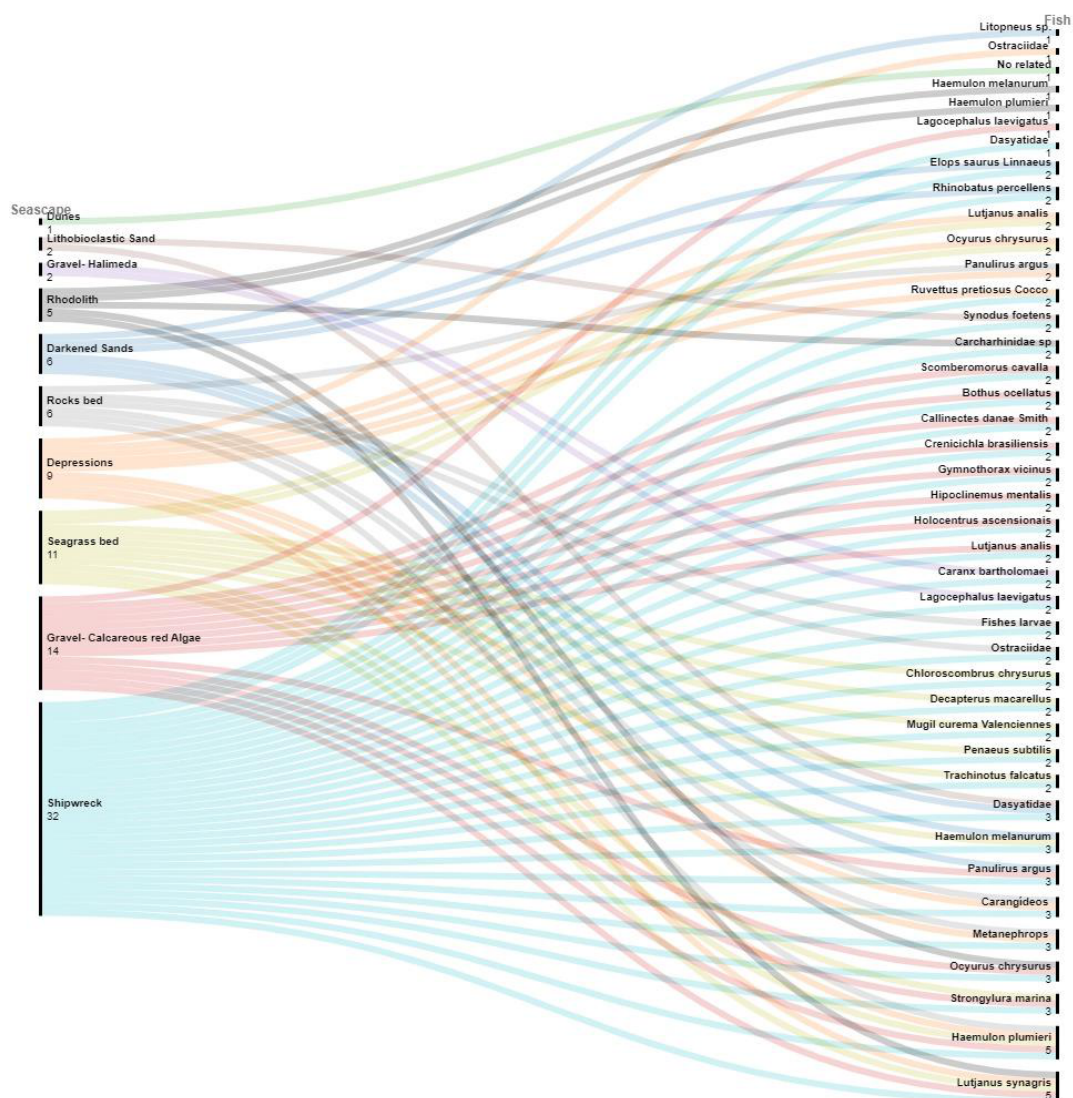
Figure 4. Species captured in seascapes based on the participatory mapping.